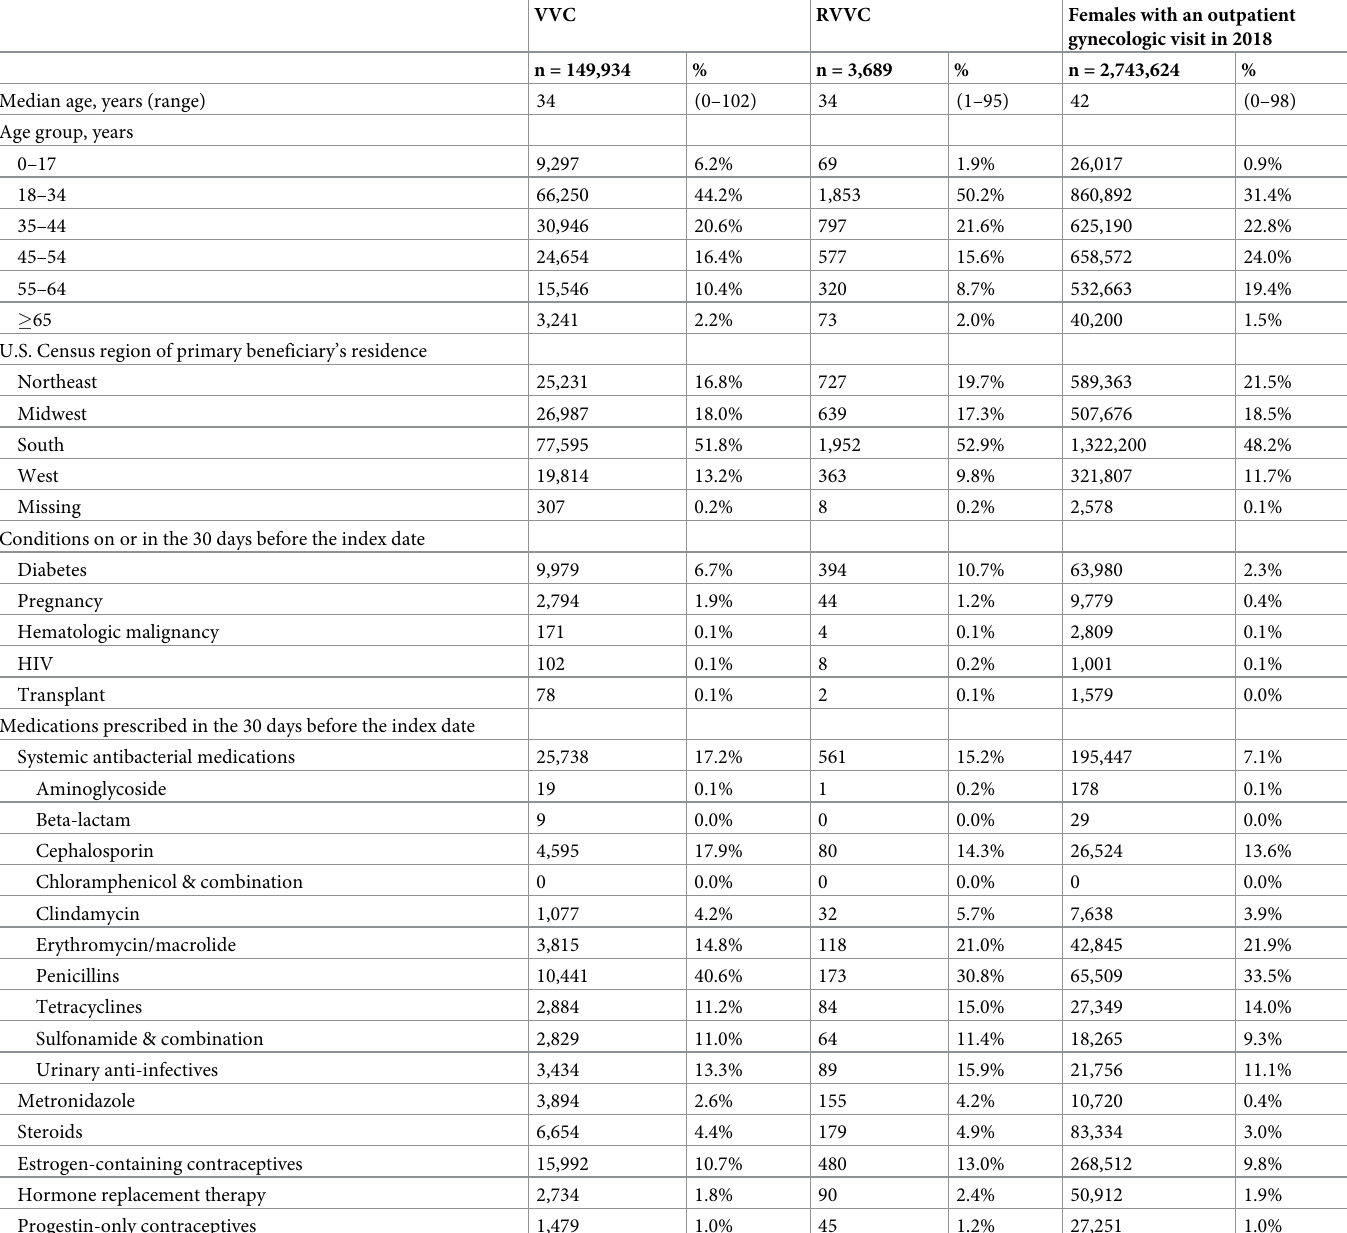
Table 1. Demographic features, underlying conditions, and pre-diagnosis medications among patients with vulvovaginal candidiasis, recurrent vulvovaginal candi- diasis, and females with an outpatient gynecologic visit.